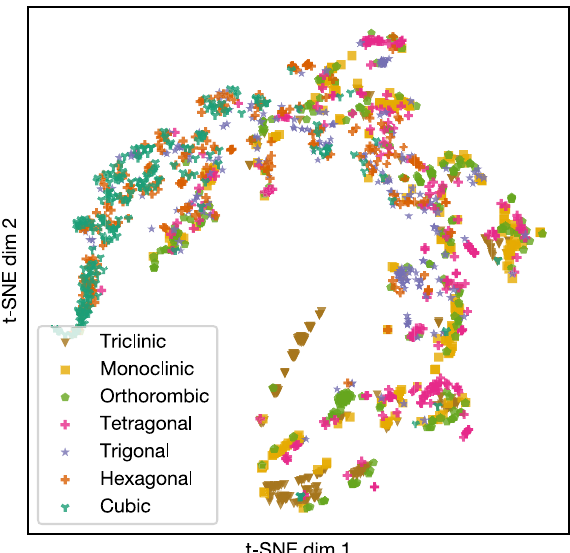
Figure 2. t-SNE visualisation of XRD patterns. Each point corresponds to one XRD pattern. XRD patterns form loose clusters for each crystal system.